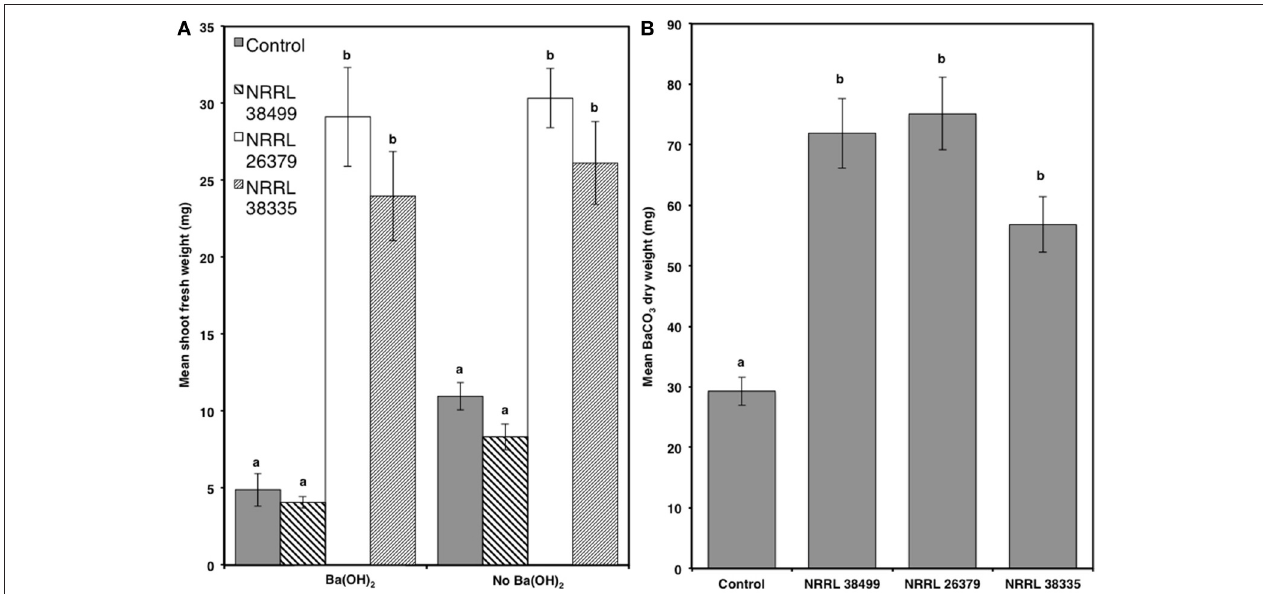
FIGURE 4 | Effect of CO 2 produced by fungal culture on plant growth. (A) Mean shoot fresh weights of Col-0 plants after 2 weeks of cocultivation with NRRL 38499, NRRL 26379, and NRRL 38335 in Y-plate in the presence and absence of Ba(OH) 2 are shown. (B) Quantities of CO 2 produced by these strains wereestimated by measuring the amount of dried BaCO 3 precipitant formed during cocultivation. Means and standard errors for six biological replicates per treatment, with three seedlings per replicate, are shown. Different letters on columns represent statistically significant differences by one-way analysis of variance.